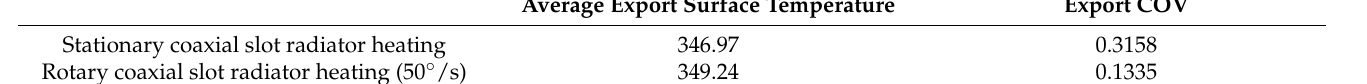
Table 3. Comparison of simulation results of rotary coaxial slot antenna and stationary coaxial slot radiator heating.